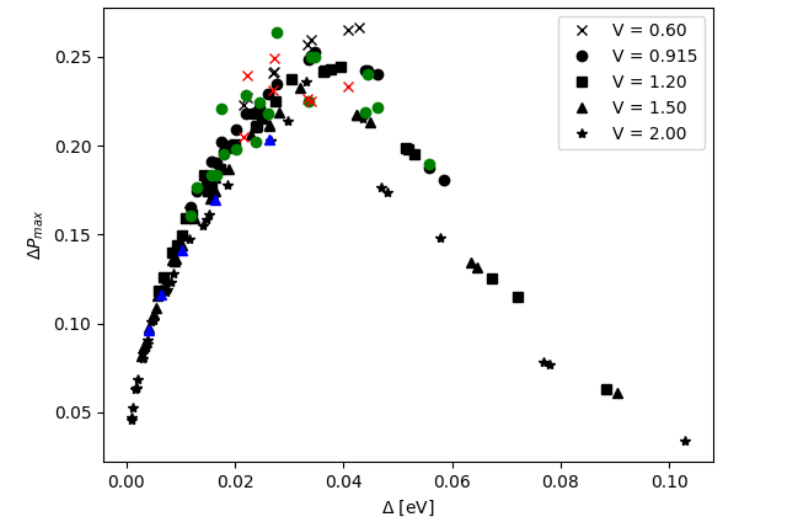
Figure 13. Maximum ∆ P corresponding to the DQDs with the energy gap ∆ ; values from the matrix model are in black and those from the electronic potential model are in other colors.